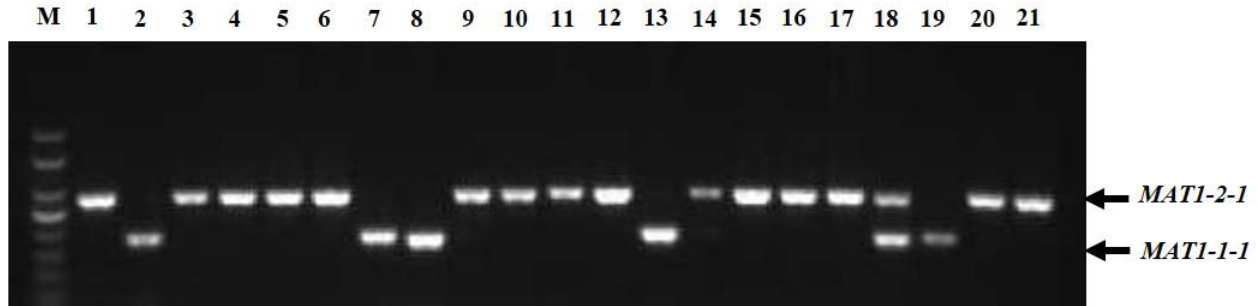
Figure 3. Multiplex PCR amplification of mating-type genes from Ustilaginoidea virens isolates. Lane M, DNA marker (Trans2K, TransGen); Lanes 1 – 21 represent isolates CDQ1-1, CDQ2-1, KMJ1-1,